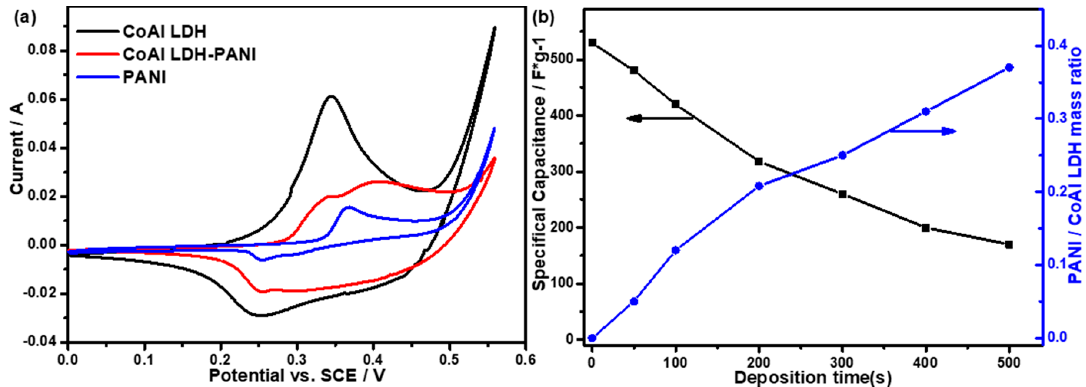
Figure 6. ( a ) CV curves of pristine PANI, CoAl LDH, and CoAl LDH-PANI composite obtained by deposition 200 s. ( b ) Specific capacitance values (obtained from CV measurement) and mass ratio of PANI: LDH for CoAl LDH-PANI electrode as a function of deposition time. (scan rate 20 mV/s)